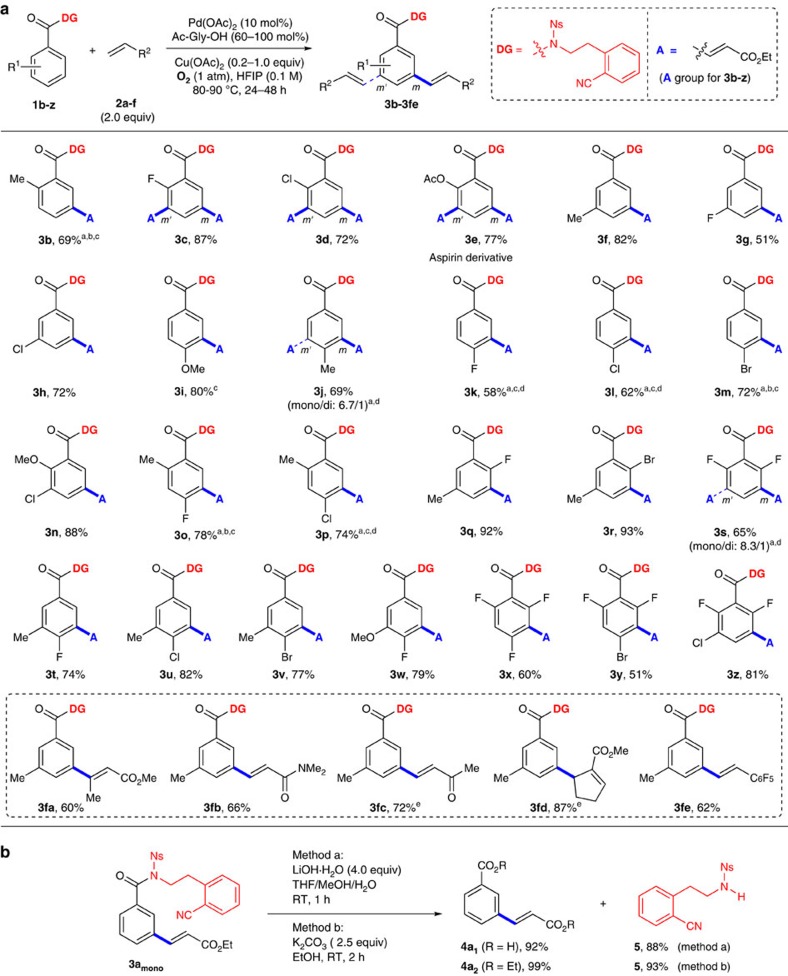
Substrate scope and removal and recycle of the template.(a) Substrate scope of meta-C–H olefination. Reaction conditions: 1 (0.1–0.2 mmol), 2 (2.0 equiv), Pd(OAc)2 (10 mol%), Ac-Gly-OH (60–100 mol%), Cu(OAc)2 (0.2–1.0 equiv), O2 (1 atm), HFIP (1–2 ml), 80–90 °C, 24–48 h, see the Supplementary Methods for details. Isolated yields are reported. aFormyl-Gly-OH (60 mol%) was used instead of Ac-Gly-OH. bKH2PO4 (0.5 equiv) was added. cA trace of (m,m')-diolefinated product was observed. dK2HPO4 (0.5 equiv) was added. eAgOAc (3.0 equiv) was used instead of O2/Cu(OAc)2. (b) Two mild methods available for regenerating auxiliary 5.